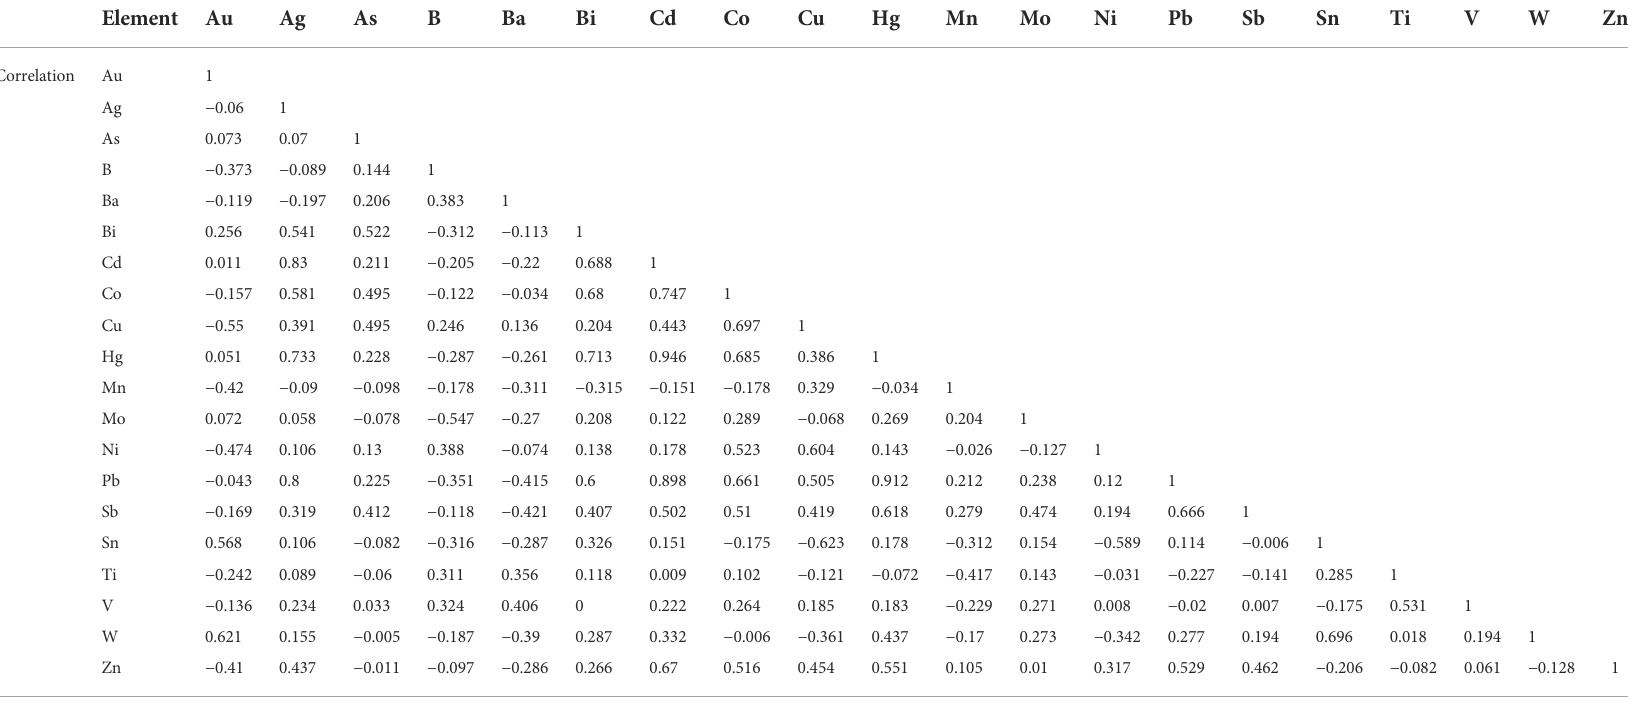
TABLE 6 Correlation matrix of 20 elements in samples from the Hongqigou tectonic zone. Element Au